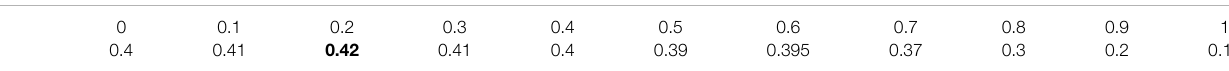
TABLE 2 | F1 values of NNP on different thresholds of WNT.